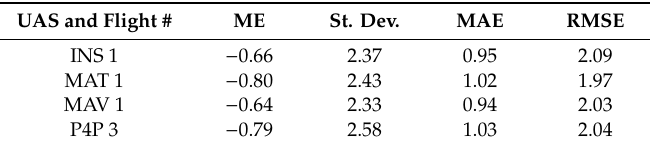
Table 5. Overall error statistics of DSMs of Di ff erence (DoDs) between the LiDAR dataset and four UAS. ME: Mean Error, St. Dev.: Standard Deviation of Error, MAE: Mean Average Error, RMSE: Root Mean Square Error. All errors reported in meters